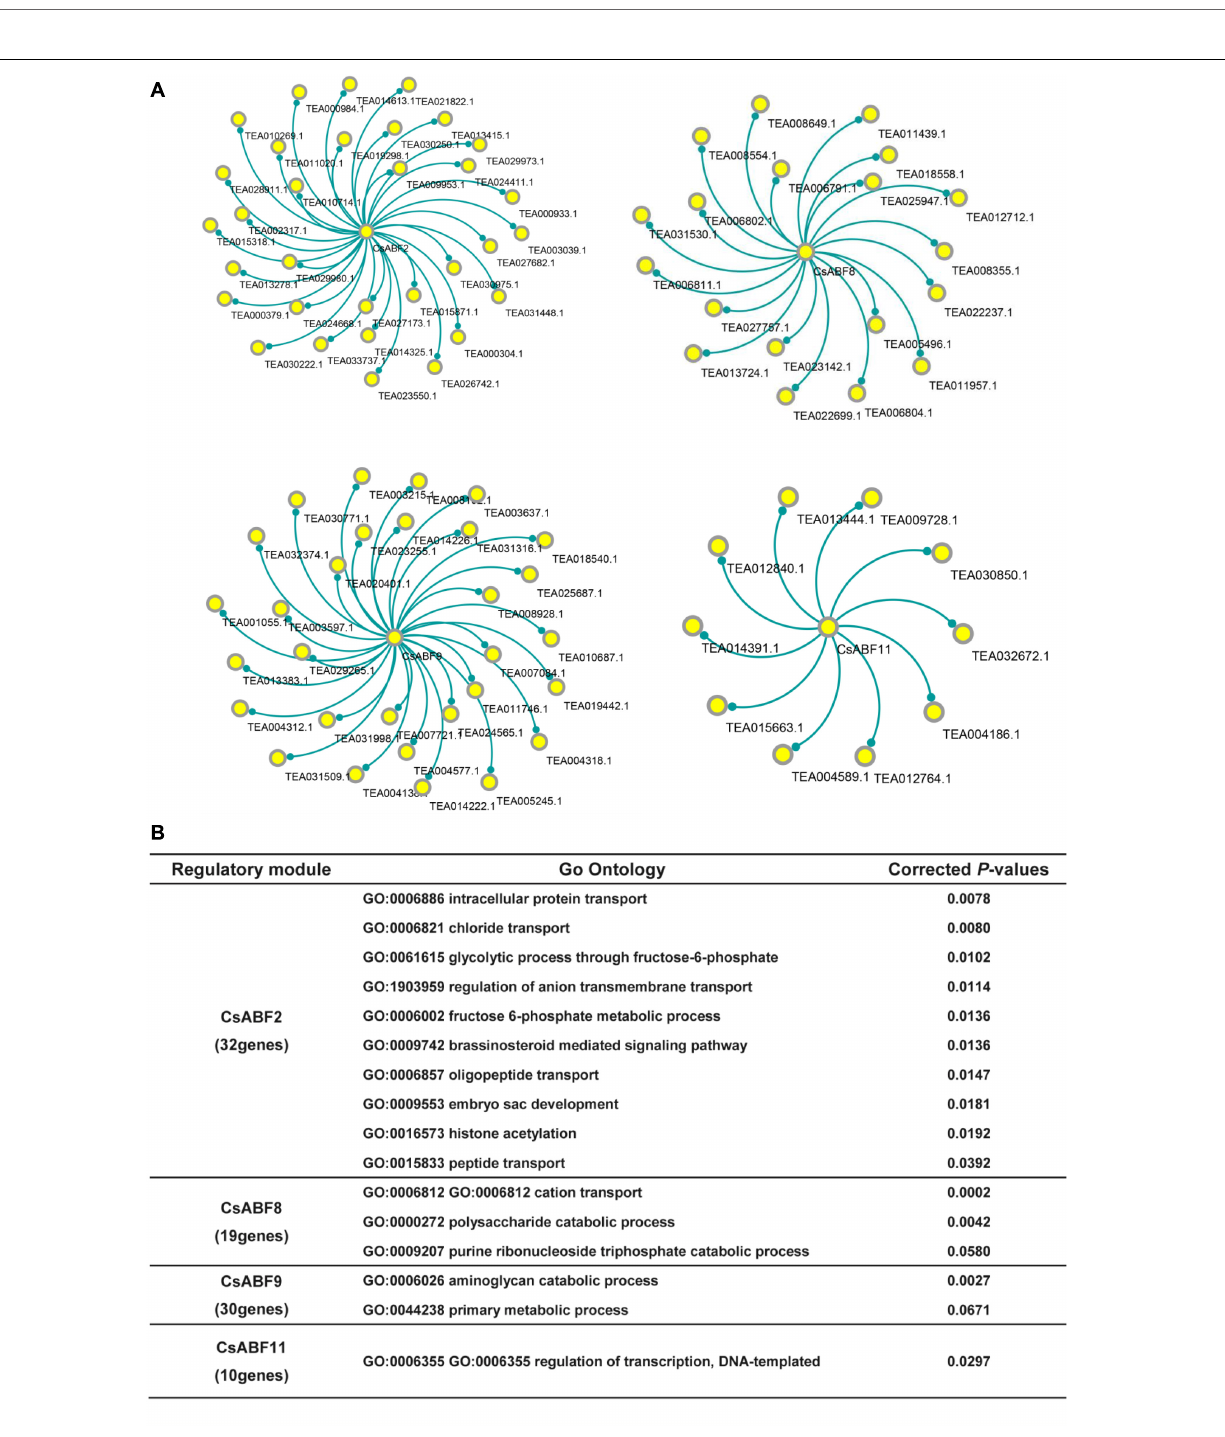
FIGURE 6 | (A) Co-expression network analysis of key TFs. The core loci are CsABF2 , CsABF8 , CsABF9 , and CsABF11 . (B) GO enrichment analysis table of candidate genes regulated by TF CsABF2/8/9/11. GO analysis will return a P -value for each GO with a differential gene, and a small P -value means that the differential gene is enriched in the